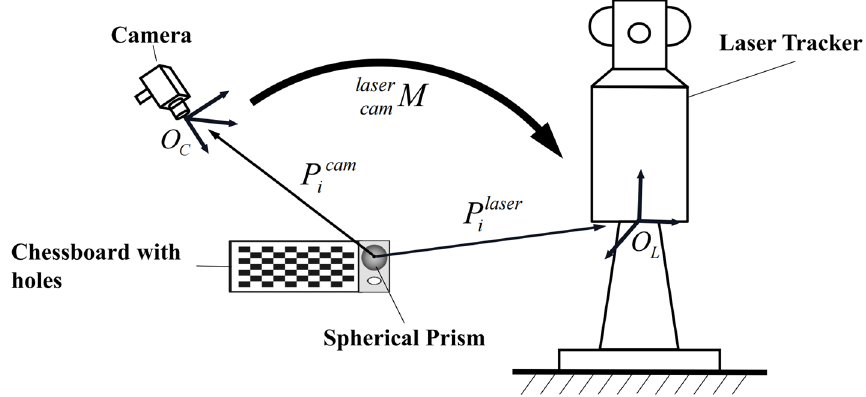
Figure 17. The schematic diagram of coordinate system conversion.